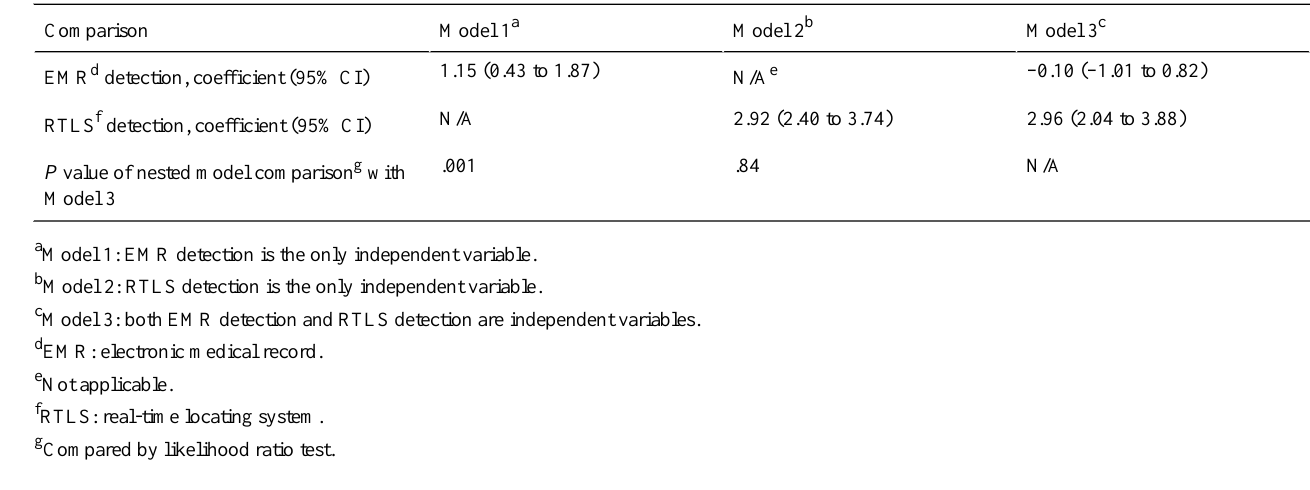
Table 4. Coefficients and comparisons of three logistic regression models for the EMR method, the RTLS method, and both methods.